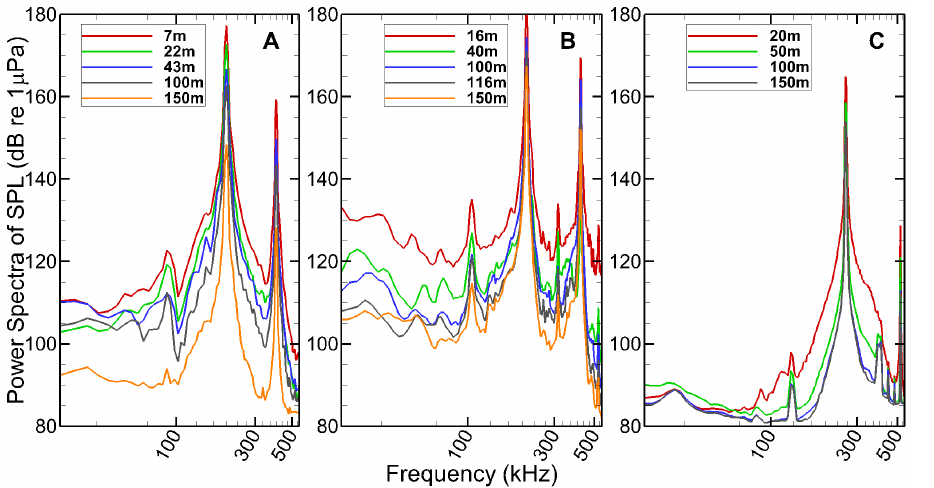
Figure 2. Sound pressure level spectra measured from different distances for the three sonar units. A . Kongsberg; B . BioSonics; C . Imagenex.